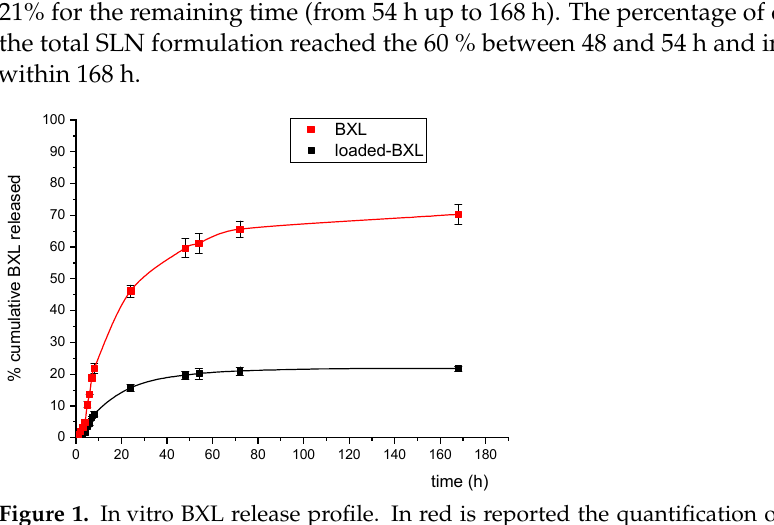
Table 3. Entrapment efficiency (EE) determination of BXL in SLN4 and SLN8. Data are reported as mean ( n = 3) ± SD.